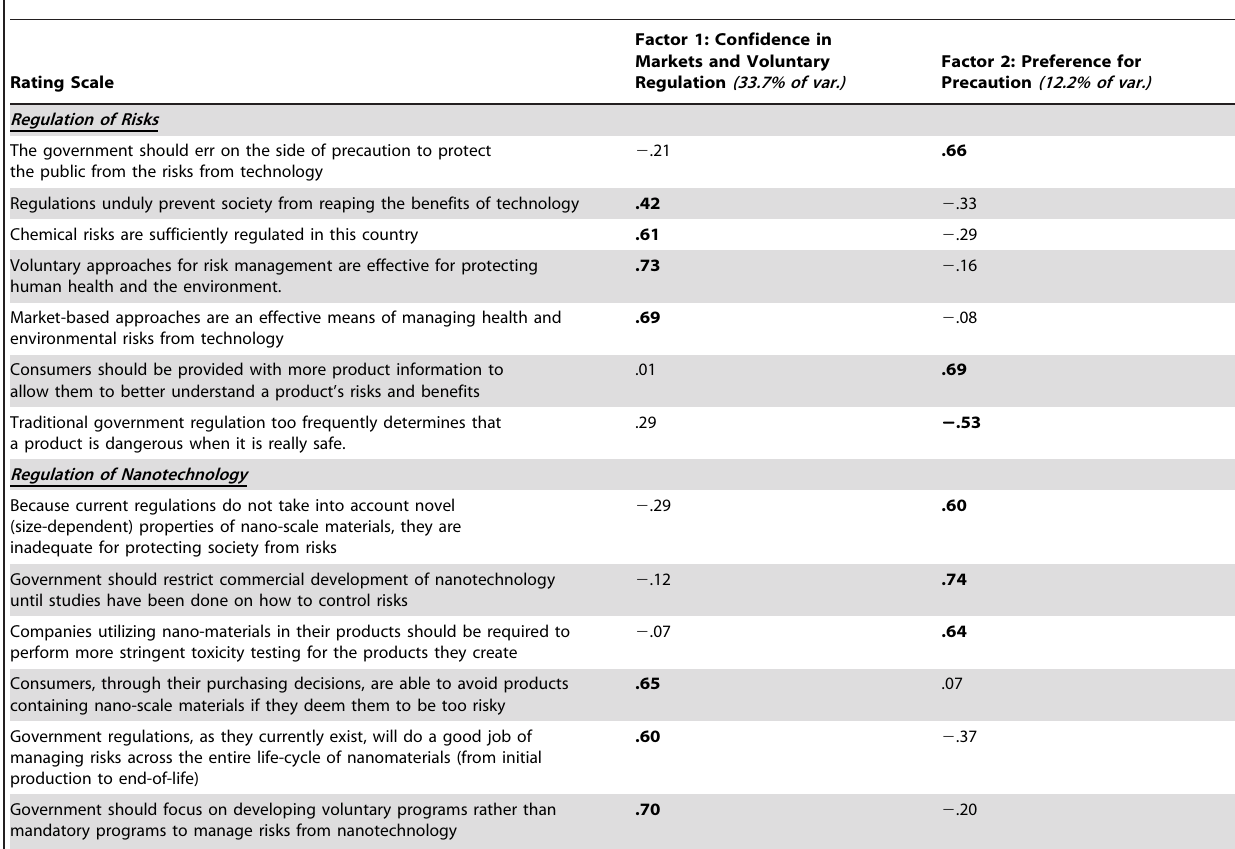
Table 3. Loadings from a principal components analysis over fourteen rating scales related to ’Regulation of Risks’ and ’Regulation of Nanotechnologies’, averaged across individuals (VARIMAX rotated solution).